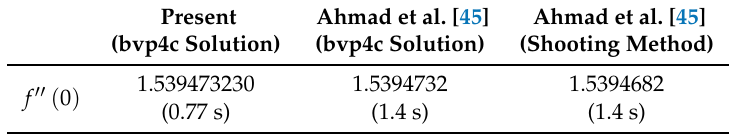
Table 4. Numerical values of f (cid:48)(cid:48) ( 0 ) for λ = φ 1 = φ 2 = 0, Z = d = 0.5, Pr = 5, and η ∞ = 20. Present Ahmad et al. [45] Ahmad et al. [45] (bvp4c Solution) (bvp4c Solution) (Shooting Method) f (cid:48)(cid:48) ( 0 )